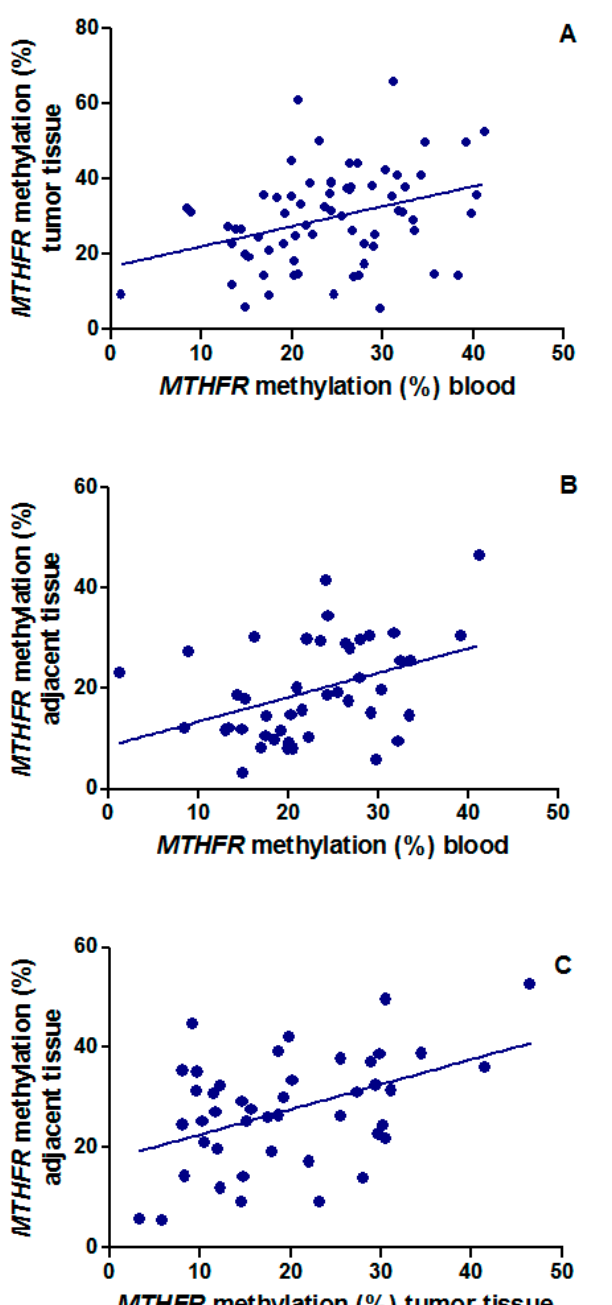
Figure 2. Correlation of MTHFR methylation levels ( A ) between tumor tissue and blood in the total population ( r = 0.34; p = 0.004); ( B ) between adjacent tissue and blood ( r = 0.40; p = 0.007); and ( C ) between tumor and adjacent thymic tissue ( r = 0.45; p = 0.002) in the subgroup of 44 individuals with available thymic tissue adjacent to the tumor; r = Pearson’s correlation coefficient.